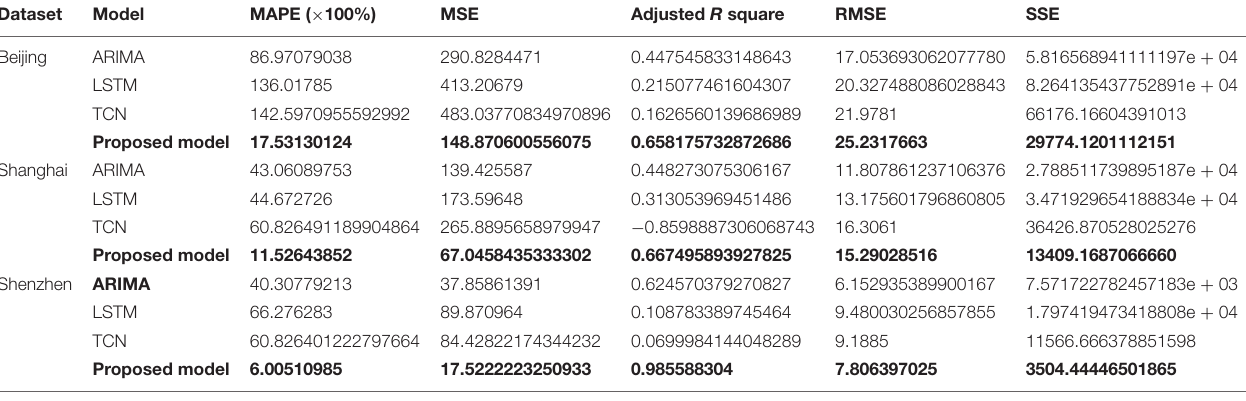
TABLE 5 | Statistical errors of the proposed system and three traditional models for daily PM 2 . 5 concentrations of Beijing, Shanghai, and Shenzhen. Dataset